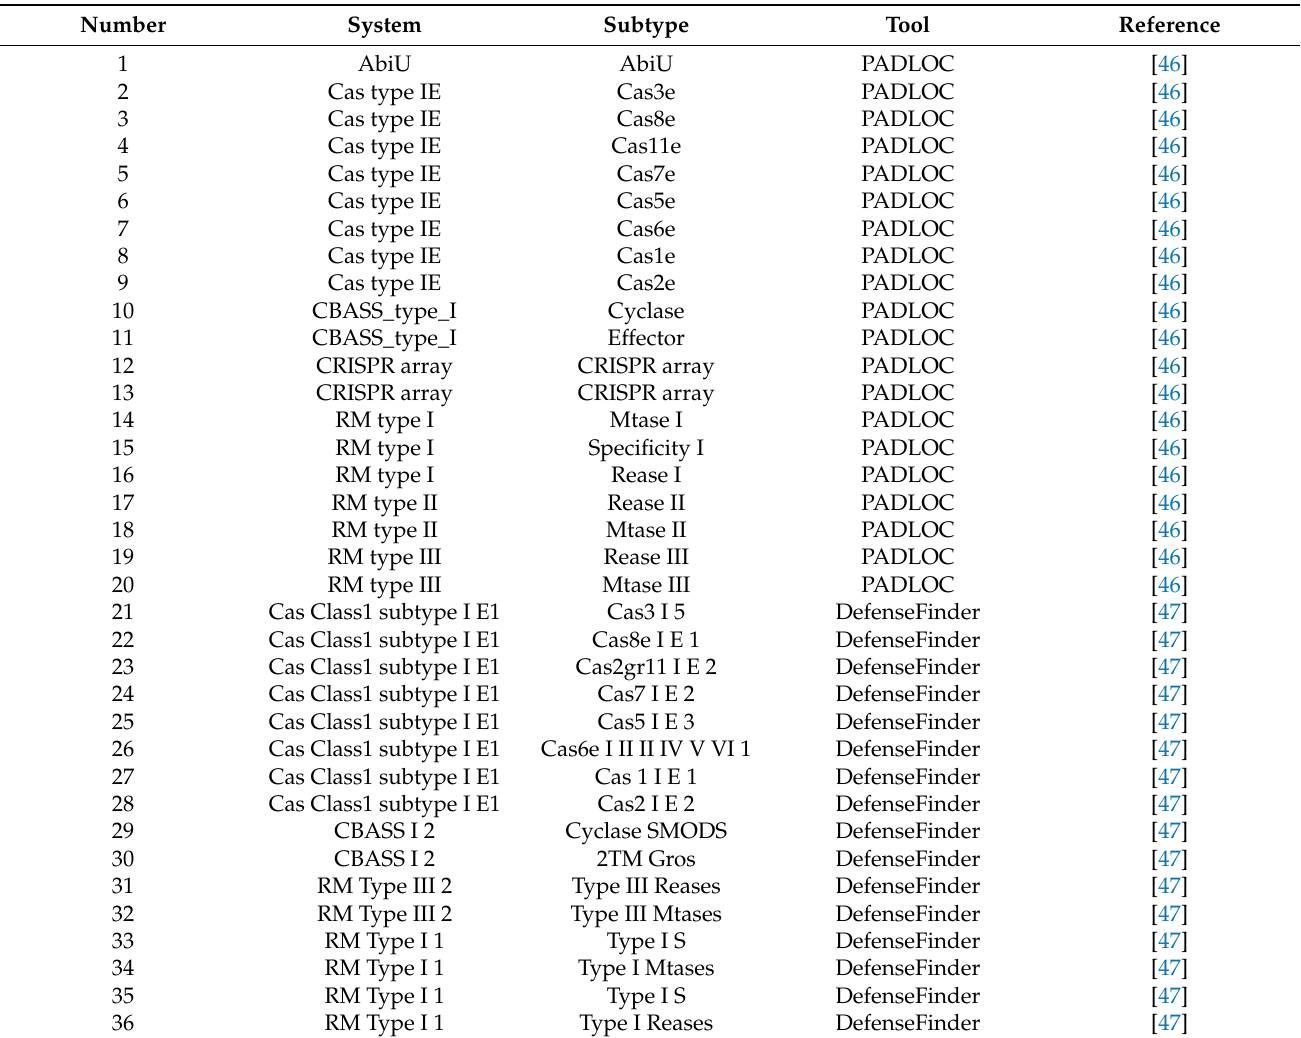
Table 6. Antiviral defense systems of Salmonella